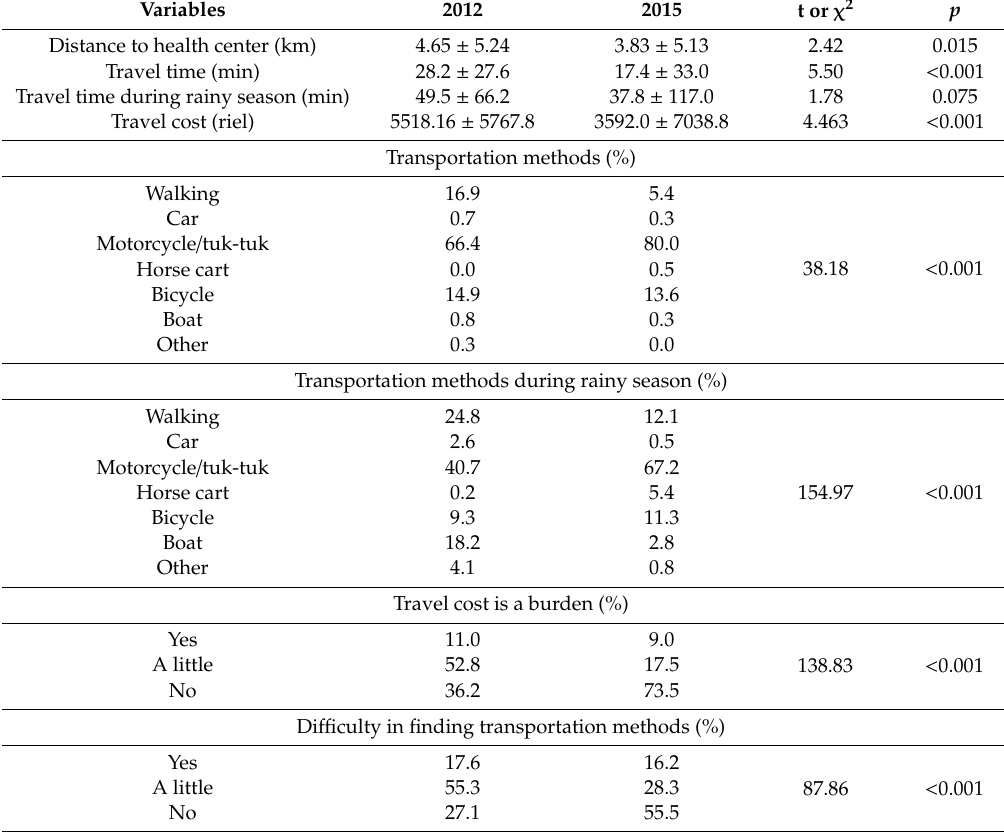
Table 4. Distribution of factors related to accessibility of maternal and child health services in 2012 and 2015 ( N =